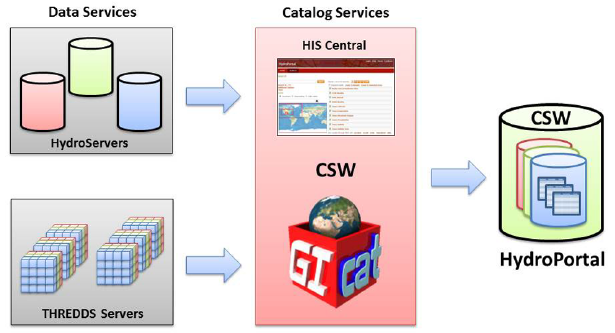
Fig. 15. Abstract diagram of interoperable data discovery system; hydrologic and atmospheric science data indexed within HydroPor-